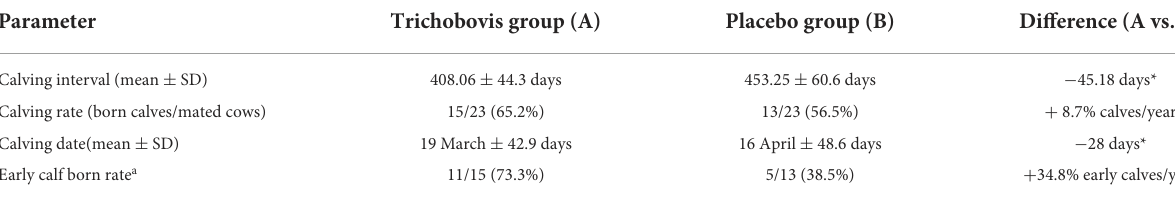
TABLE 2 Comparison of the reproductive data between animals vaccinated with Trichobovis group (A) and Placebo group (B).